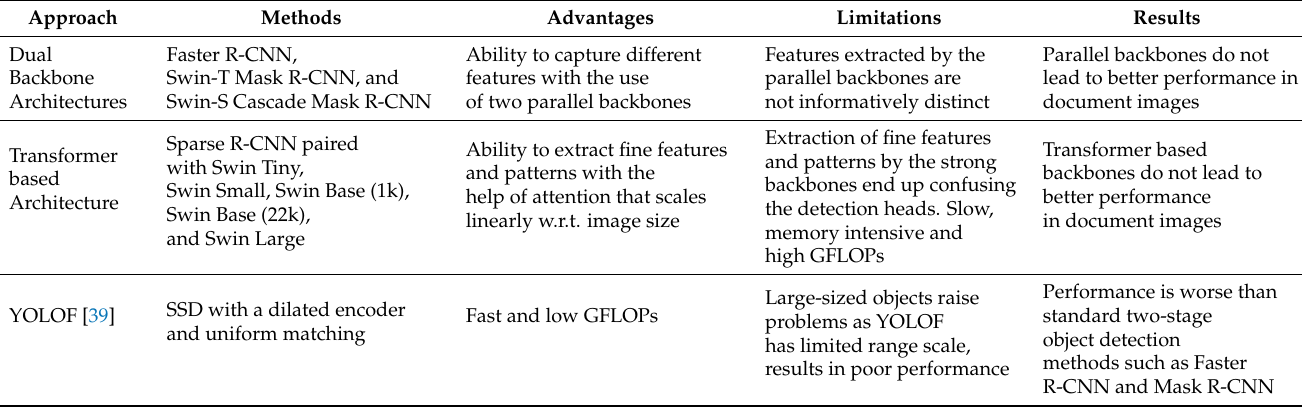
Table 1. Comparison of the key characteristics of the explored approaches with prior work in the domain, along with their advantages, limitations, and